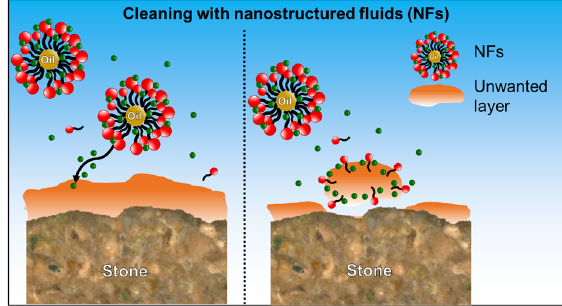
Figure 1. The selective action of aqueous nanofluids (NFs) for the removal of unwanted layers from stone. Considering that NFs can solubilise the ingredients of the protective materials, they can be considered as an innovative “green” approach in the cleaning of surfaces [12, 15].